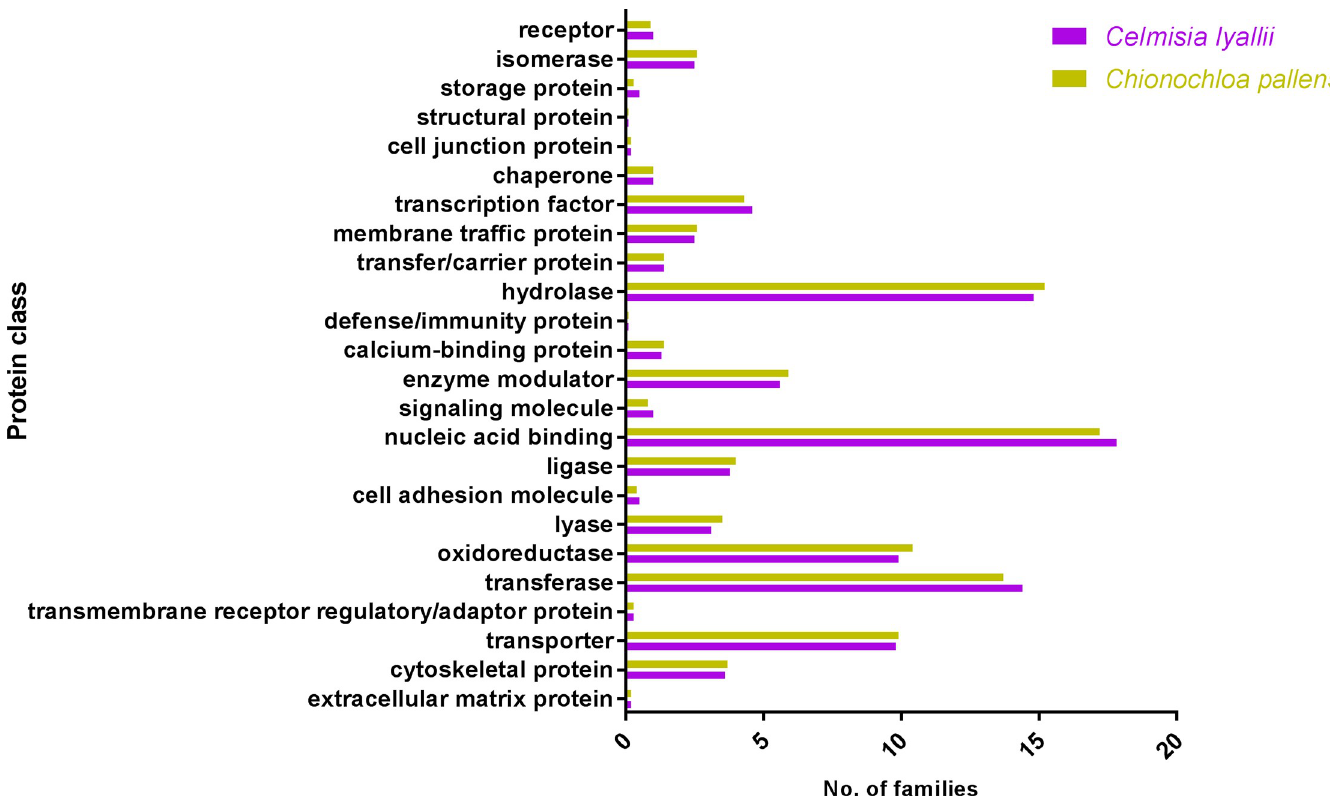
Fig 3. Identification of different protein classes. Categorisation of the peptide sequences predicted from the assembled transcriptome of C . lyallii and C . pallens .